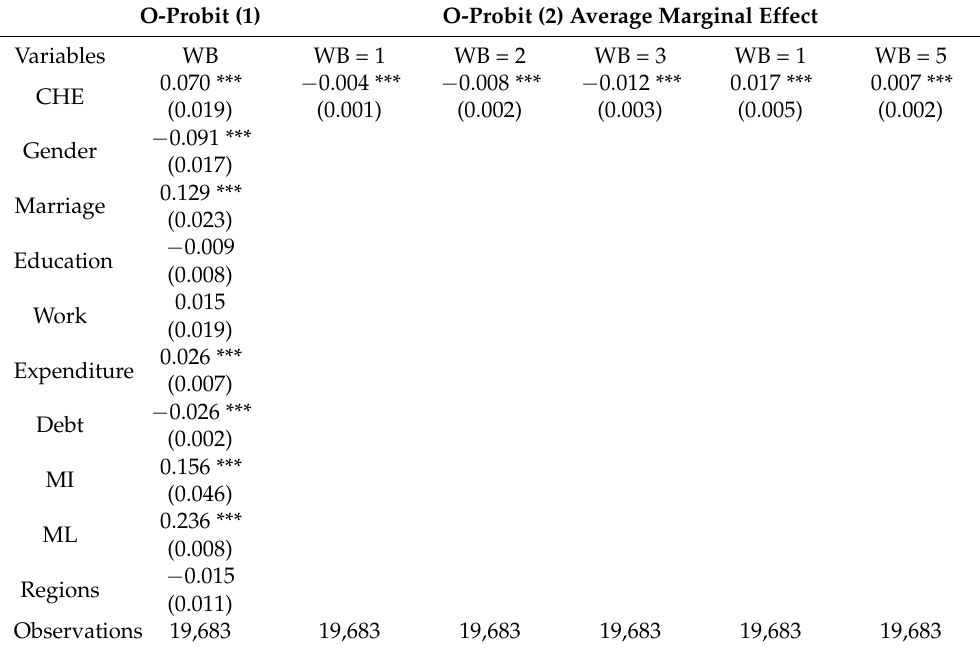
Table 3. The regression results of CHE and